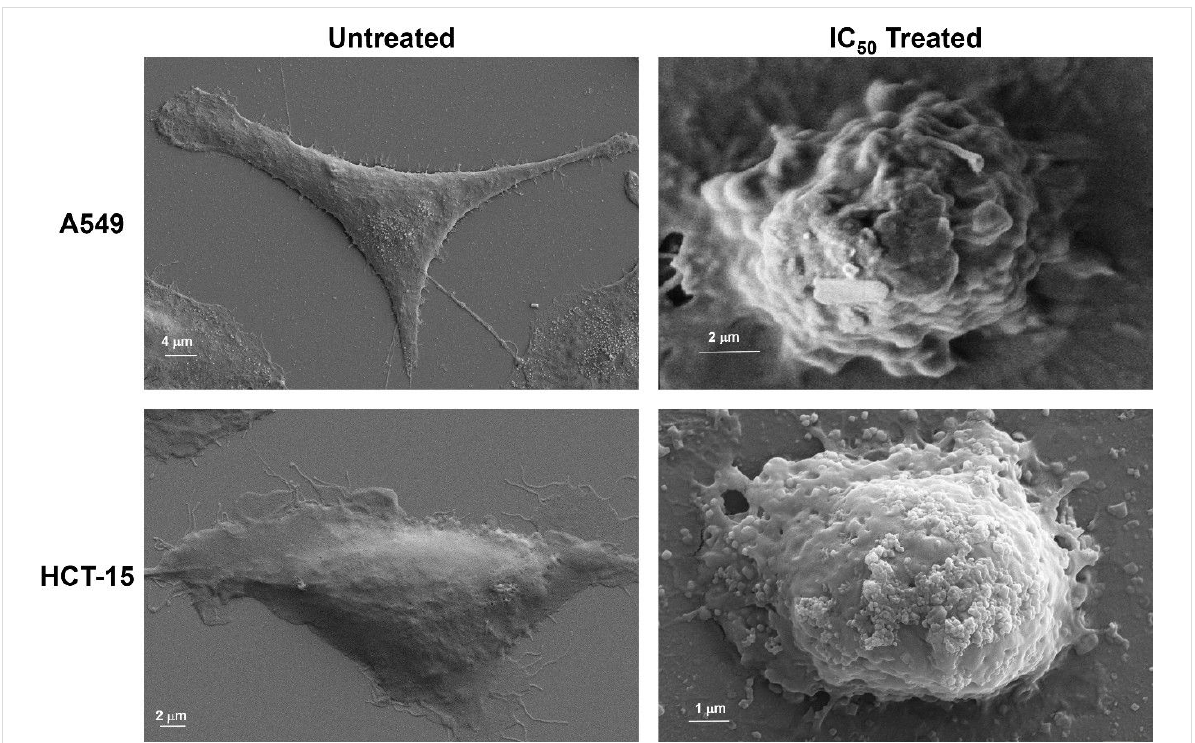
Figure 6: FE-SEM micrograph of untreated control cells A549 and HCT-15 along with CaP@5-FU treated cells at IC 50 concentration.